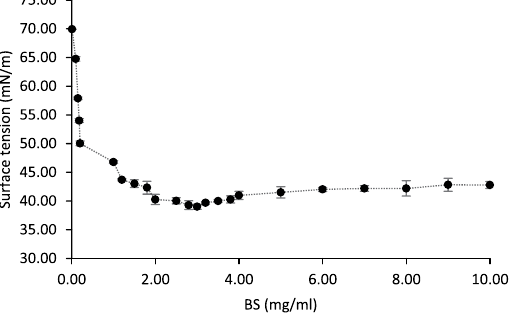
Figure 2. Progressive decrease in ST with increase in BS concentration up to 2.7